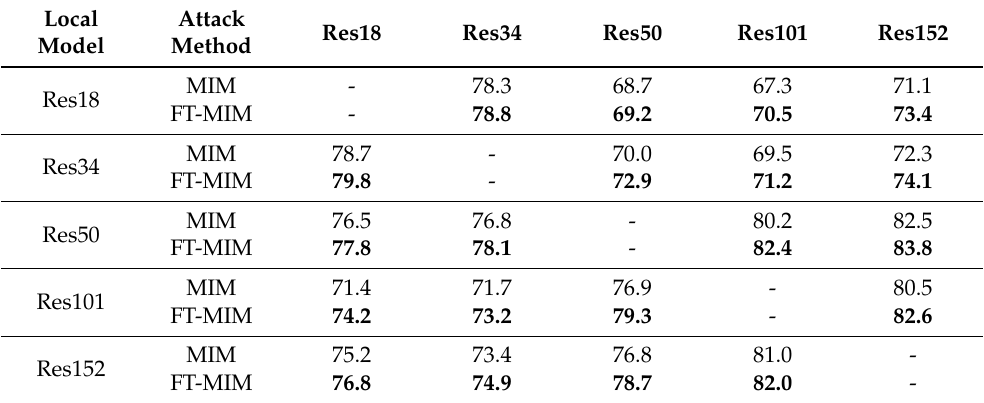
Table 7. The black-box ASRs of MIM (MI-FGSM) and FT-MIM (FT-MI-FGSM) on Cifar10. The first column is the local model, and the first row is the target model. The values in the table are the ASRs (%) on the target models using the adversarial examples generated with the local models. The higher ASRs are shown in bold.